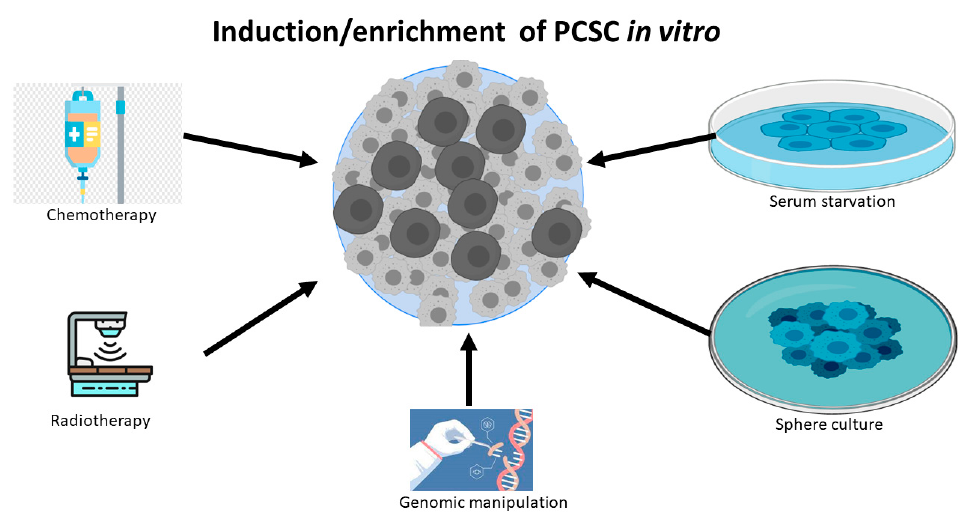
Figure 1. PC cell lines can be de-differentiated to PCSCs or stem-like PC cells by chemotherapy, radiotherapy, serum starvation, sphere culture, and genomic manipulation. radiotherapy, serum starvation, sphere culture, and genomic